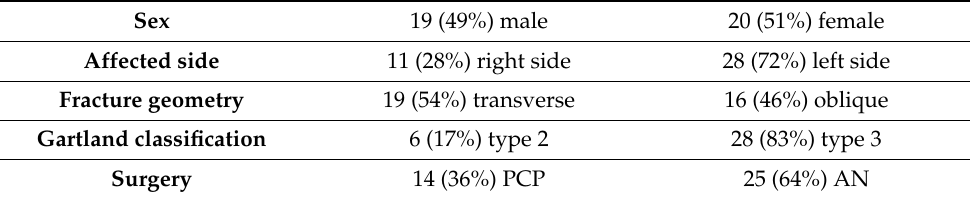
Table 1. The study population of 39 patients with supracondylar humerus fracture and postoper ative